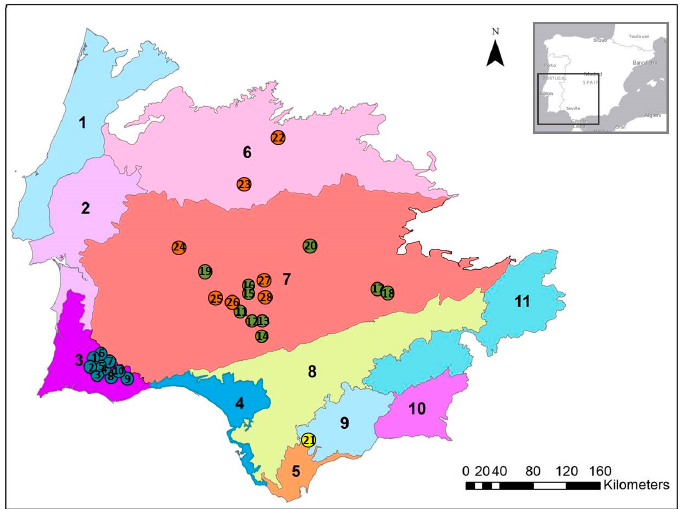
Figure 1. Biogeographic map of the southwest of the Iberian Peninsula at sector level, following [2] (1–Divisorio-Portuguese Sector; 2–Ribatejo and Sado Sector; 3–Algarve and Monchique Sector; 4– Cádiz and Littoral Huelva Sector; 5–Algeciras and Aljibe Sector; 6–Oretana Range and Tajo Sector; 7–Mariánica Range Sector; 8–Campiña of Guadalquivir Sector; 9–Ronda Sector; 10–Granada and Almijara Sector; 11–Subbética Sector). Numbers of dots correspond to those of Table 1 and Figure 2.